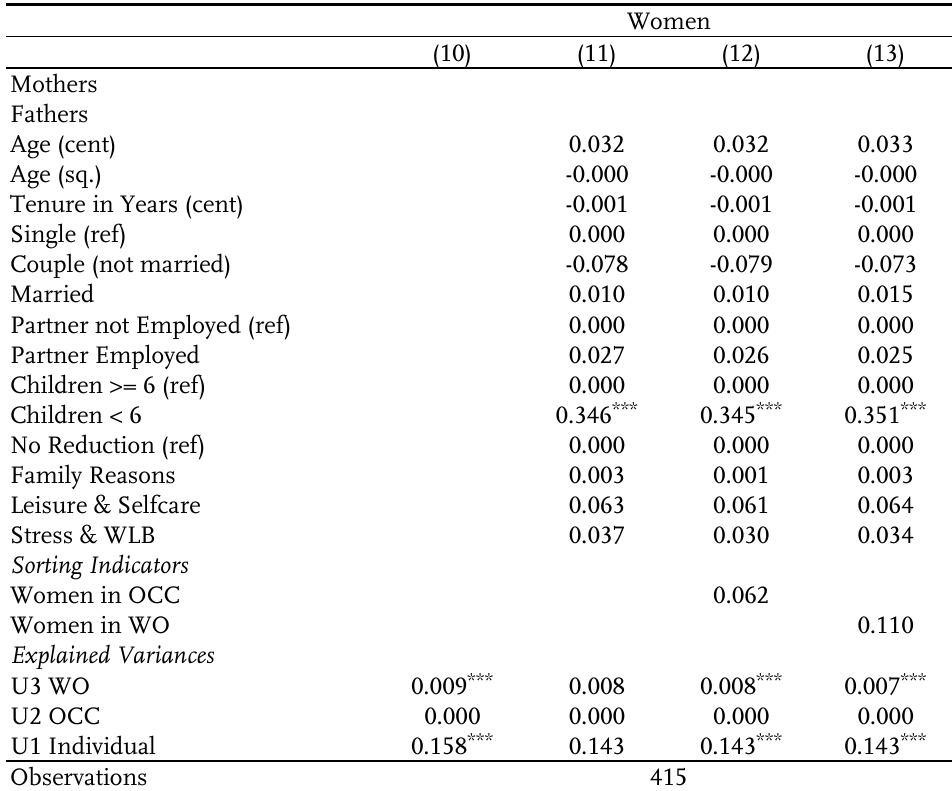
Table A.3 : Cross classified multilevel model on reduction of contracted working hours (2 hour threshold)